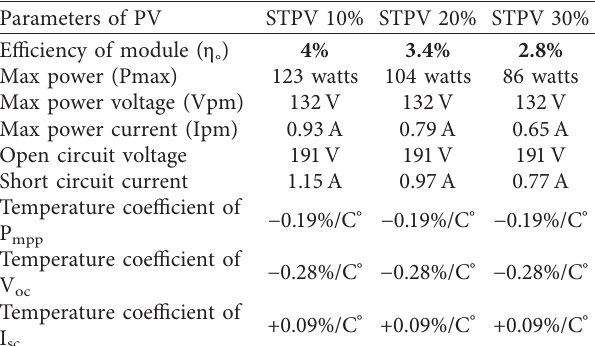
Table 3: Input electrical parameters of various STPV transparencies.